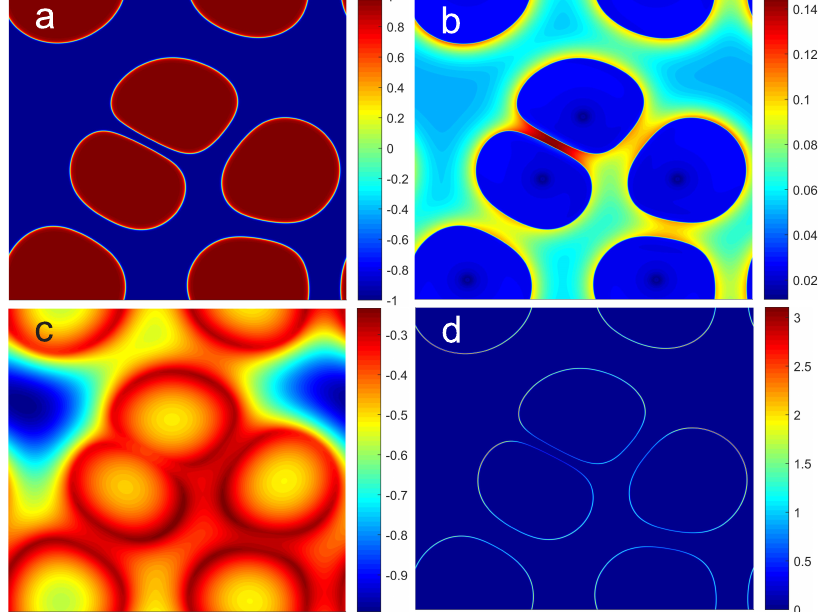
Figure 2. Snapshots of the scaled simulation results at time instant (cid:101) t = 1.5, showing ( a ) phase field φ s (cid:96) that distinguishes the ice crystals (red) and liquid mixture (blue), ( b ) solute volume fraction φ c due to freeze concentration, ( c ) temperature distribution (cid:101) T that shows the exothermic effect, and ( d ) positive (freezing, or negative upon melting) volumetric flow rate (cid:101) ∇ · (cid:101) v induced at the ice/freeze concentrate interface due to density variation. Initial conditions are (cid:101) T = − 1.0 (or dimensional temperature T 0 − 10 K), φ c = 0.05 (about 7.7 wt %), and a rapid cooling rate with β f = 100 K/s or volumetric heat sink ˙ Ω = ρ c p β f (cid:39) 2 × 10 8 J/m 3 · s, and the simulation has time scale τ s (cid:96) = 0.4762 s, length scale 10 µ